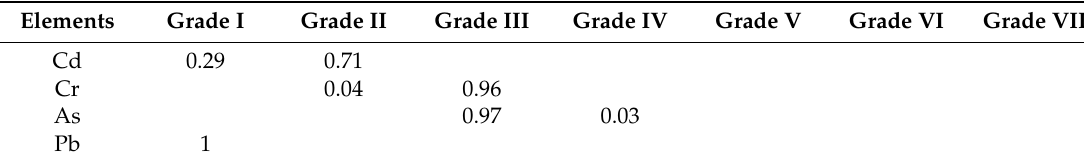
Table 7. Reliability degrees of each trace element in surface water from Honghu Lake in different health risk